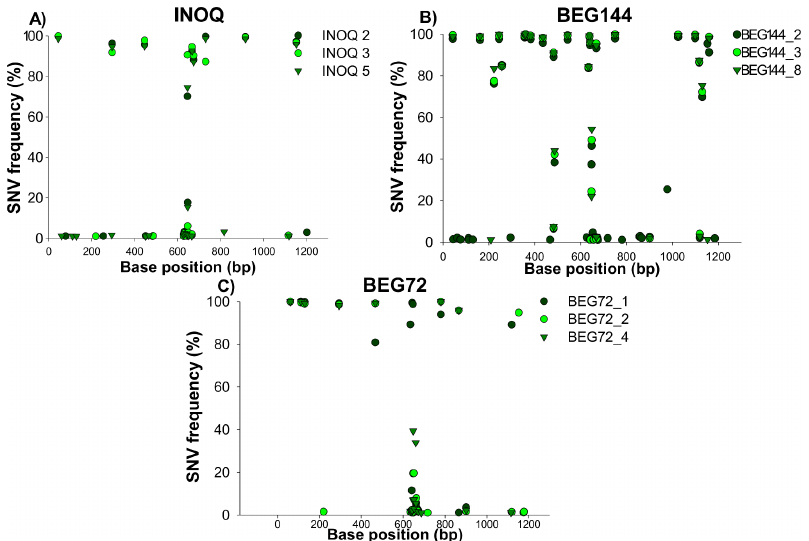
Fig 7. Frequency of SNVs along the RiAOX sequence on the INOQ, BEG144 and BEG72